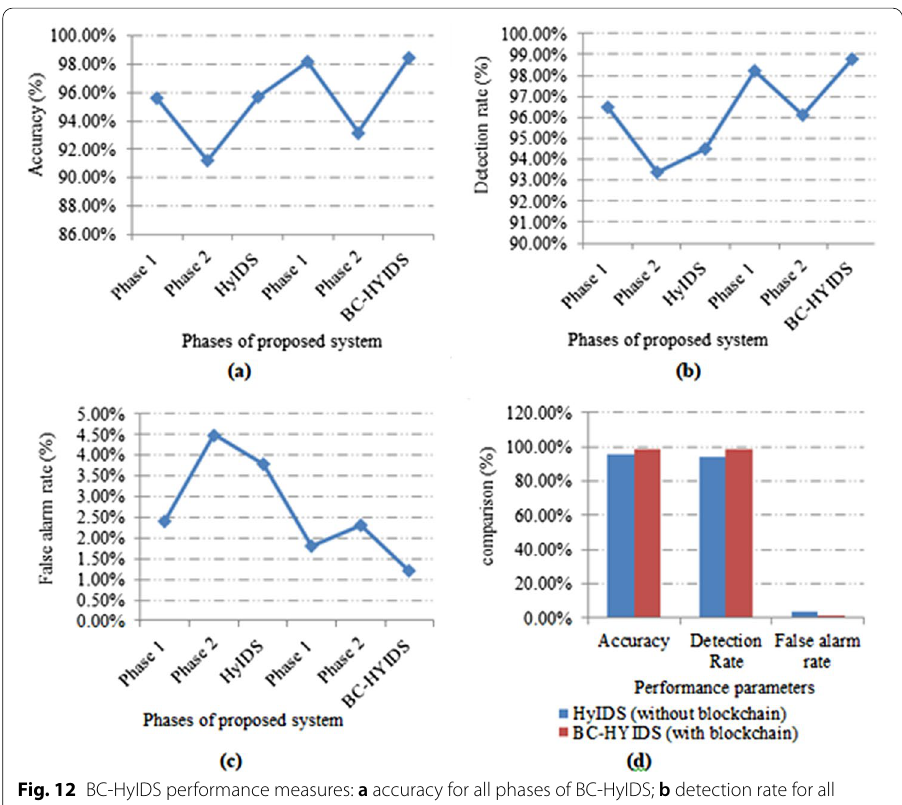
Fig. 12 BC-HyIDS performance measures: a accuracy for all phases of BC-HyIDS; b detection rate for all phases of C-HyIDS; c false alarm rate for all phases of BC-HyIDS and d comparison of BC-HyIDS with and without blockchain. Performance of BC-HyIDS as a single system is tested using various parameters. These all parameters are tested with and without blockchain. a Accuracy for all phase of BC-HyIDS when used with and without blockchain is represented. b Detection rate for all phase of BC-HyIDS when used with and without blockchain is represented. c False alarm rate for all phase of BC-HyIDS when used with and without blockchain is represented. d Comparison of whole system when used with and without blockchain is graphically represented in terms of accuracy, detection rate and false alarm rate